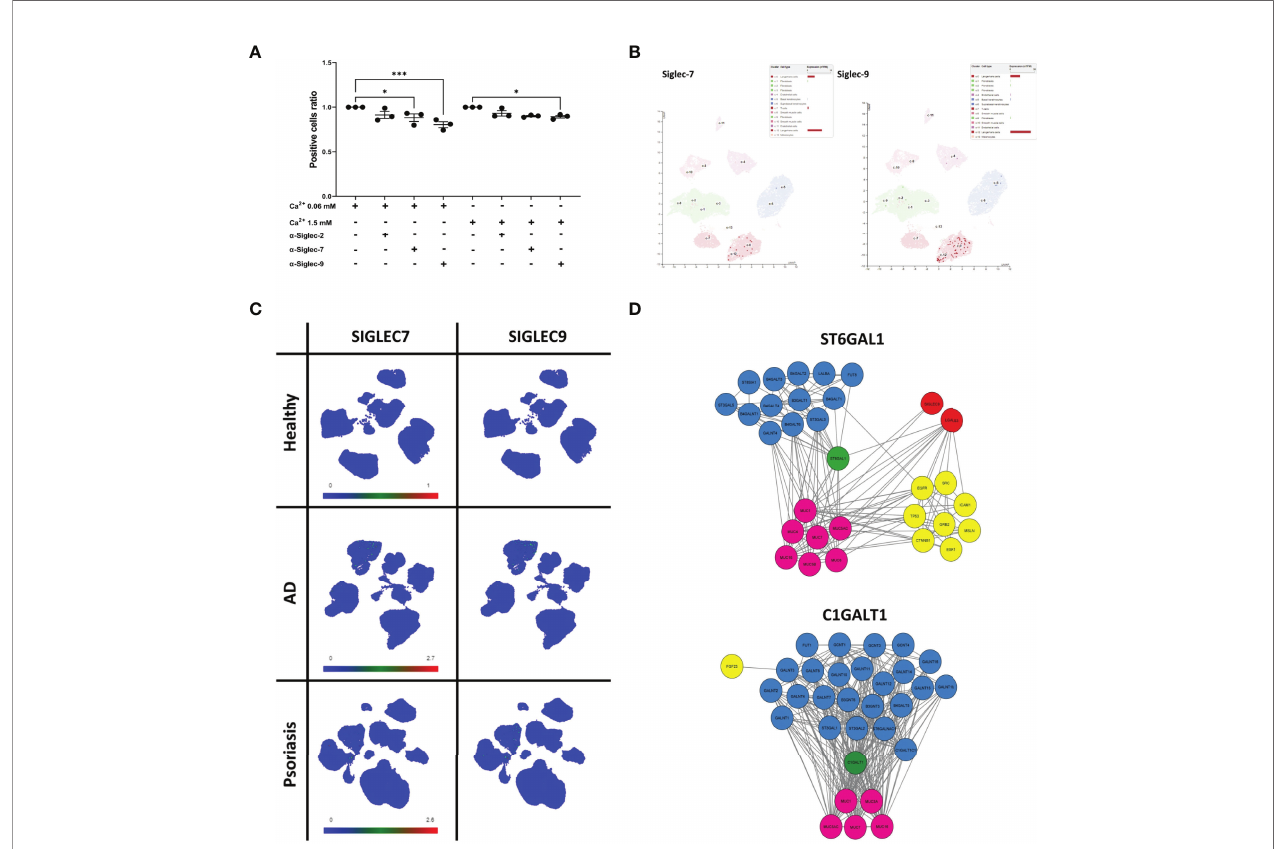
FIGURE 6 | Sialyltransferase ST6GAL1 is implicated in sialylation pattern on keratinocyte-derived sEVs and de fi nes their cell interaction propensity via Siglec-7 and Siglec-9 receptors. (A) Identi fi cation of binding receptors for sEV N/TERT-1 cell interaction by blocking experiments with anti Siglec-type receptors on differentiated THP-1 cells; combined data for n=3 biological replicates; (B) single-cell RNA expression levels of Siglec-7 and Siglec-9 in the epidermis of the skin; data available through ProteinAtlas; (C) UMAP plots of single cell expression of SIGLEC7 and SIGLEC9 receptors in the skin; data avalabale through Human Developmental Cell Atlas; (D) protein interaction network of ST6GAL1 and C1GALT1 enzymes obtained via STRING analysis. * - p<0.05, *** -